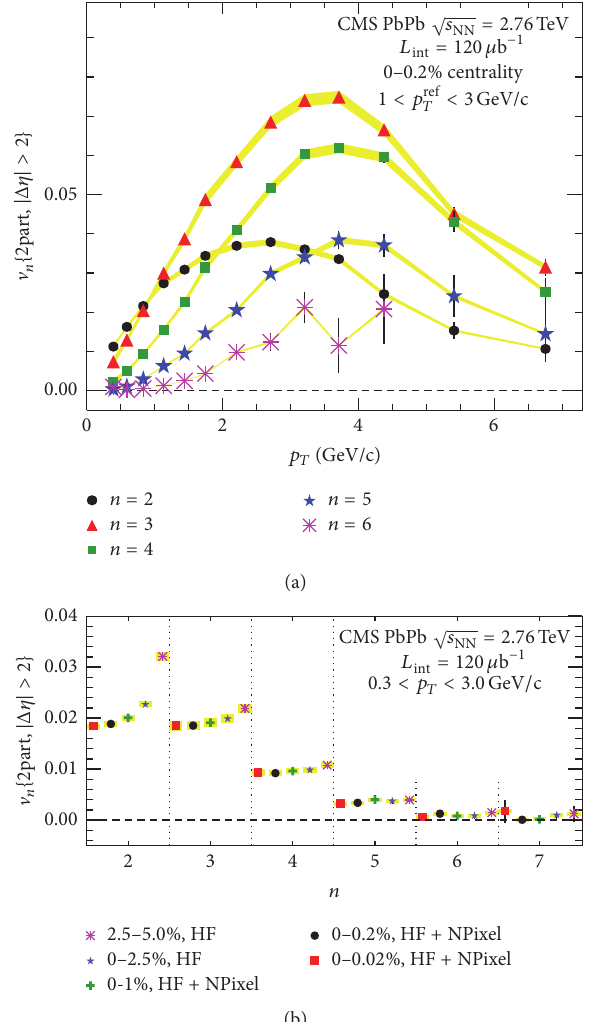
Figure 8: (a) V 𝑛 ( 𝑛 = 2 –6) values as a function of 𝑝 𝑇 in